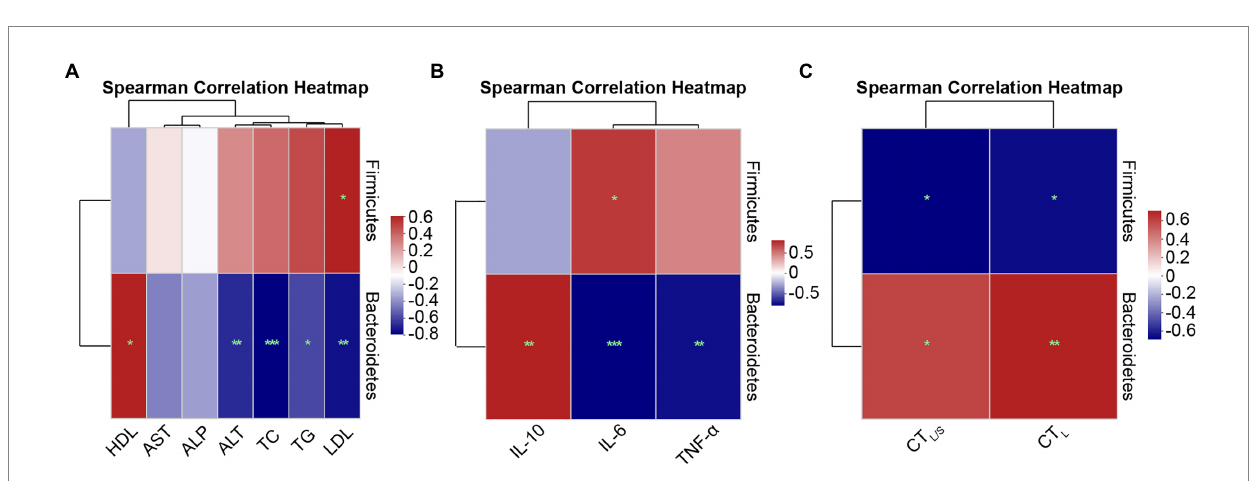
FIGURE 9 Spearman correlation heatmaps at the phylum level. (A) Correlation heatmap of the serum lipid metabolism parameters ALT, AST, ALP, TC, TG, HDL, and LDL with the intestinal microbiota. (B) Correlation heatmap of the inflammatory factors IL-6, TNF- α , and IL-10 with the intestinal microbiota. (C) Correlation heatmap of the hepatic steatosis indicators CT L and CT L/S with the intestinal microbiota. Red indicates a positive correlation, and blue indicates a negative correlation; the darker the color, the higher the correlation. Significance threshold, * p < 0.05, ** p < 0.01, *** p <